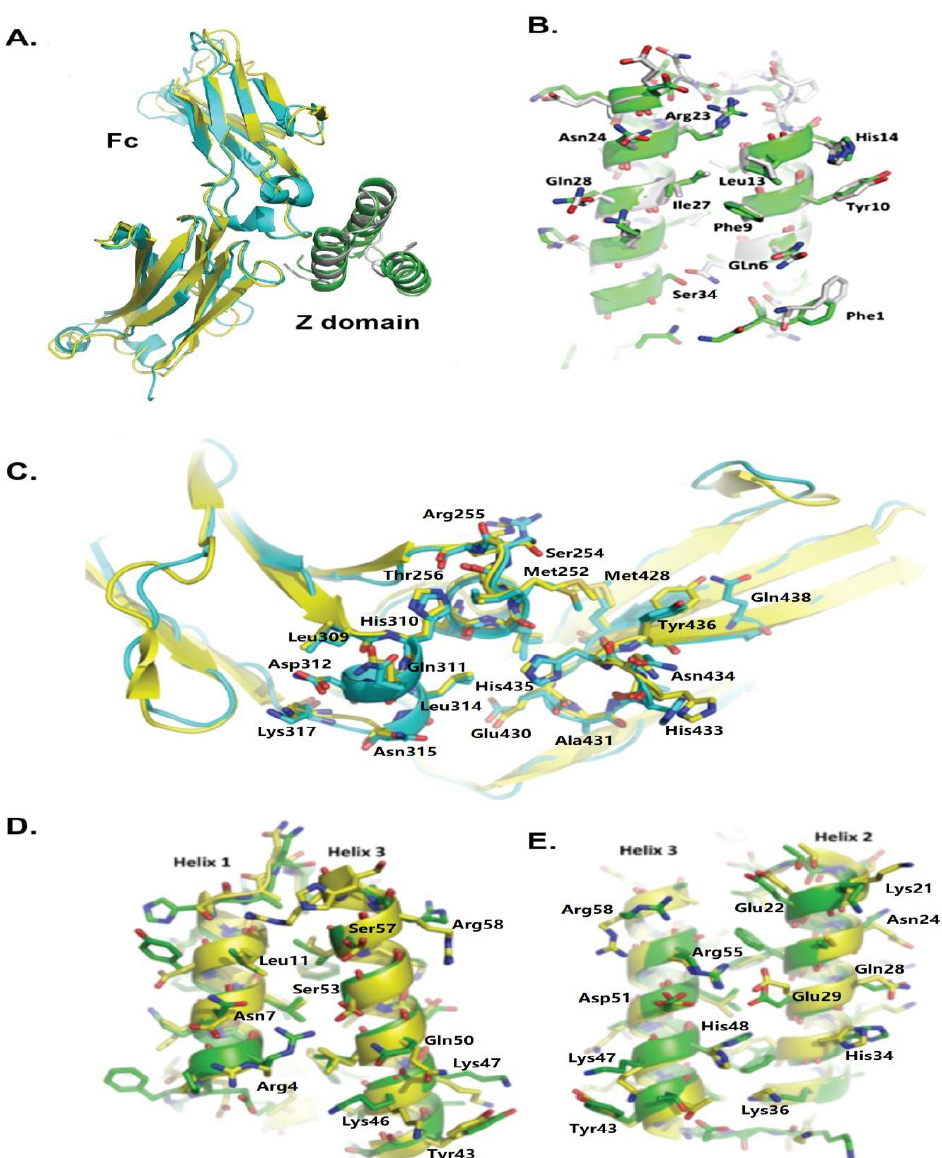
Figure 2. Crystal structure of HED domain. ( A ) Structure alignment of the complexes of the Fc fragment of IgG1with the HED domain and the B domain of SpA (PDB: 1FC2). The structure models are shown as illustrations: the B-domain of the SpA and HED domains are colored grey and green and the Fc fragment in PDB 1FC2 and in complex with HED are colored yellow and cyan. ( B ) Structure alignment of the HED domain and B-domain (1FC2). The residues in the B-domain and the HED domain involved in the interaction of the Fc fragments are shown as sticks on their illustrated structure. The carbon atoms in the B-domain and the HED domain are painted in grey and green. ( C ) Structure alignment of the Fc fragment in the complexes with the B-domain (PDB: 1FC2) and the HED domain. On their illustrated model, the residues in the Fc fragments involving the interaction with the B-domain or the HED domain are shown as sticks with their carbon atoms in yellow and cyan, respectively. ( D , E ). Structural alignment of the HED domain with the region of alpha-2-MRAP used for modeling. The models are shown as illustrations and the side chain atoms of HED, and alpha-2-MRAP are presented as sticks on illustrations and their carbon atoms are colored green and yellow,